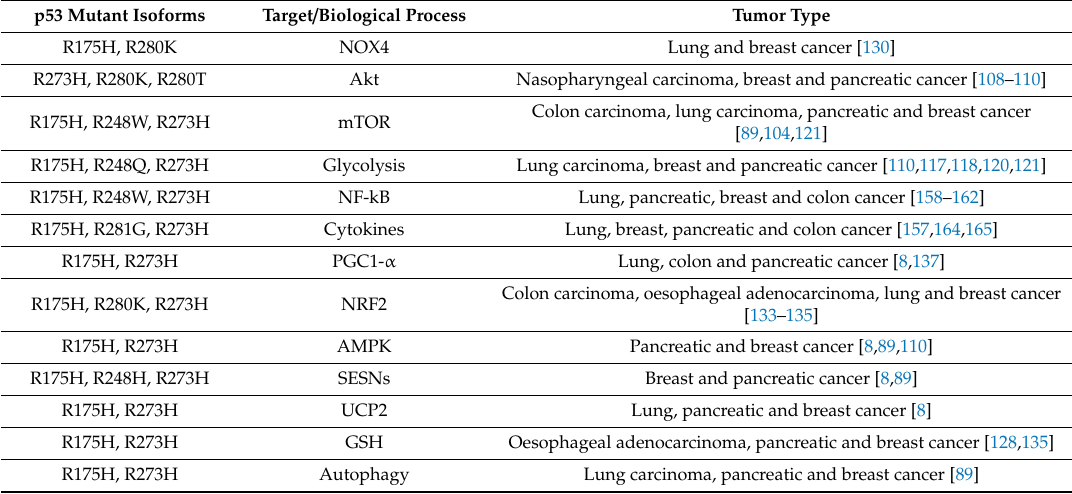
Table 1. List of mutant p53 isoforms regulating di ff erent molecular targets and biological process in various tumor